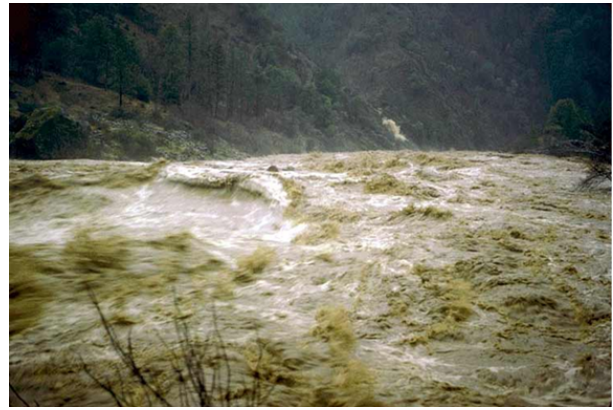
Fig. 3. Example of valley-confined flood in the Swiss